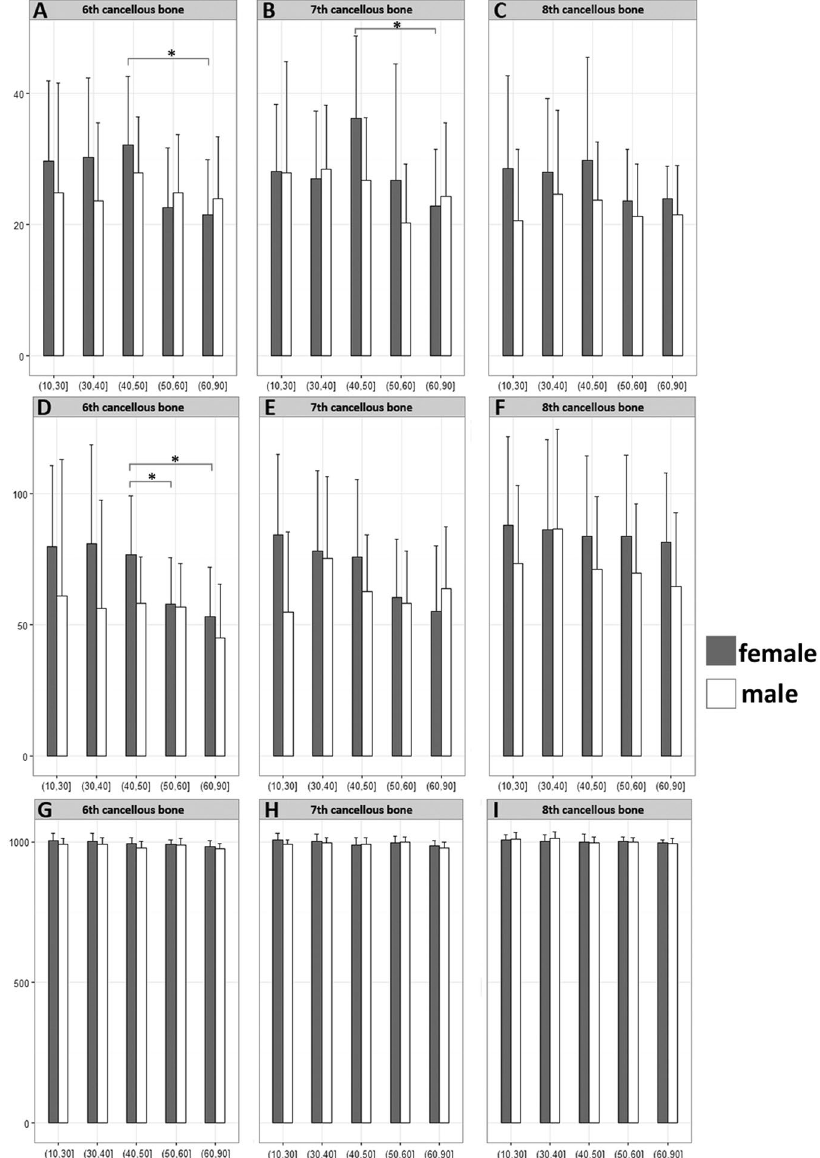
Figure 4. The measurement results of costal cancellous bone. ( A , B , C ) The calcium concentration of costal cancellous bone in different groups. ( D , E , F ) The CT values of costal cancellous bone in different age groups. the CT value and calcium concentration of costal cancellous bone decreased gradually since the 50 years old in female patients, whereas this two values were similar in male patients in all groups. ( G , H , I ) The water concentration of costal cancellous bone in different groups. * P <